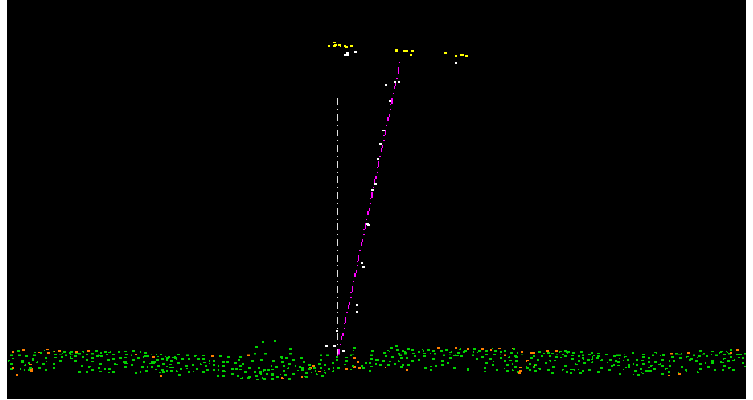
Figure 4. An unusual inclination of the 22 kV line distribution tower.